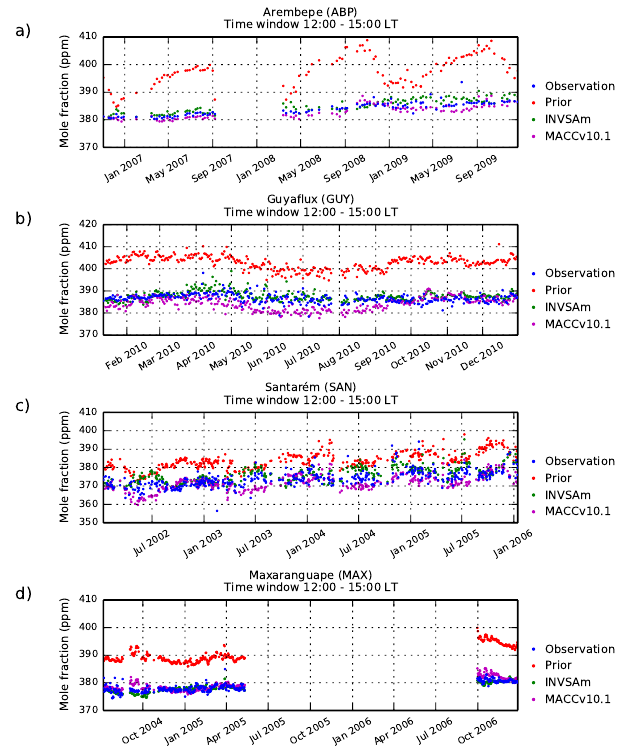
Figure 4. Comparison of assimilated CO 2 observations (blue) and corresponding simulated mole fractions using prior fluxes (red), INVSAm (green) and MACCv10.1 (purple). Measurements were collected at Arembepe (a) , Guyaflux (b) , Santarém (c) and Maxaranguape (d) . Data shown here correspond to daily aver- age mole fractions between 12:00 and 15:00LT, when wind speed > 2ms − 1 . Note that the timescale differs between